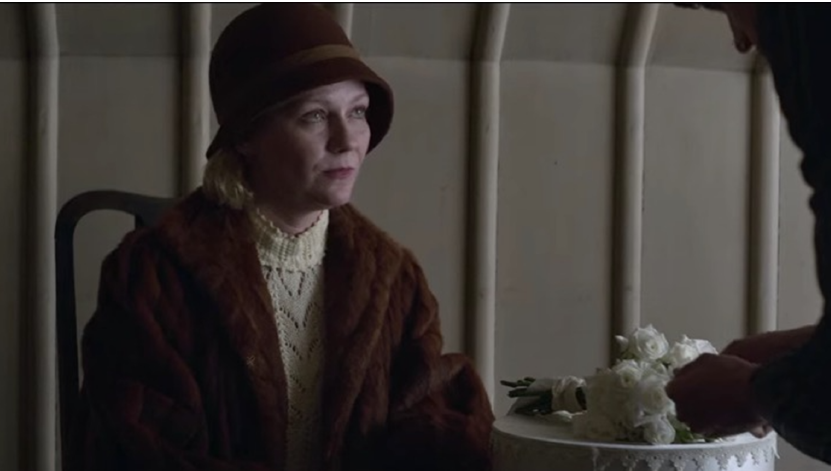
Figure 2. The Power of the Dog . Netflix.